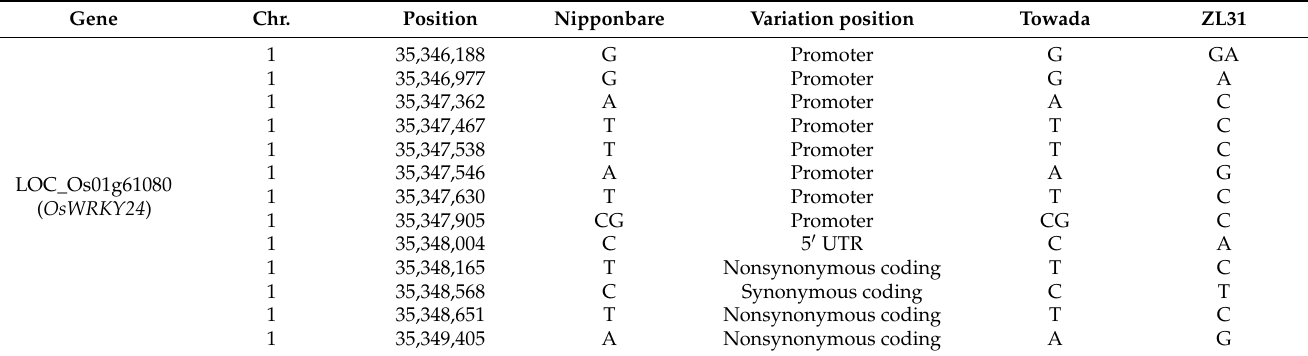
Table 2. The sequence variations of the candidate genes between Towada and